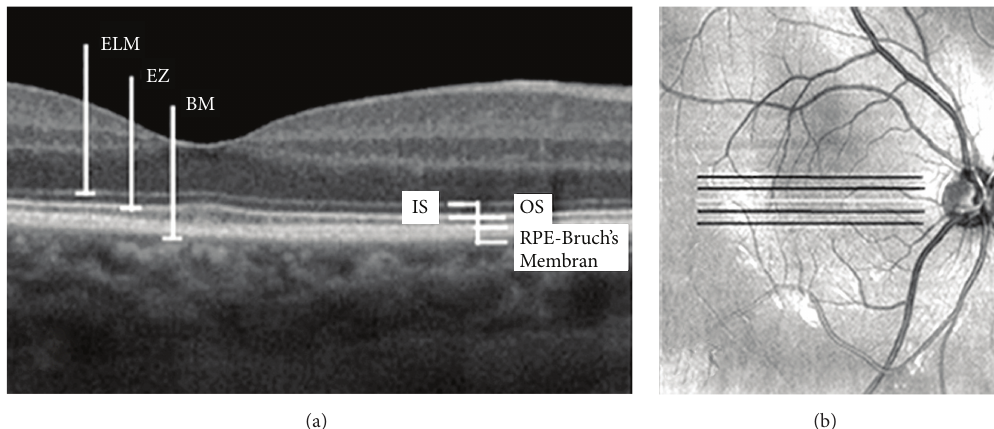
Figure 1: Spectral-domain optical coherence tomography (SD-OCT) horizontal scan (passing through the foveal center) image of a healthy right eye. High-definition imaging with SD-OCT allows detailed description of the retinal structures. The retinal layers are labeled from the top to the bottom as external limiting membrane (ELM), ellipsoid zone (EZ), and retinal pigment epithelium- (RPE-) Bruch’s membrane complex. Table 1: Demographic characteristics and clinical data of users of hydroxychloroquine and controls. Hydroxychloroquine users Controls 𝑃 value Mean ±